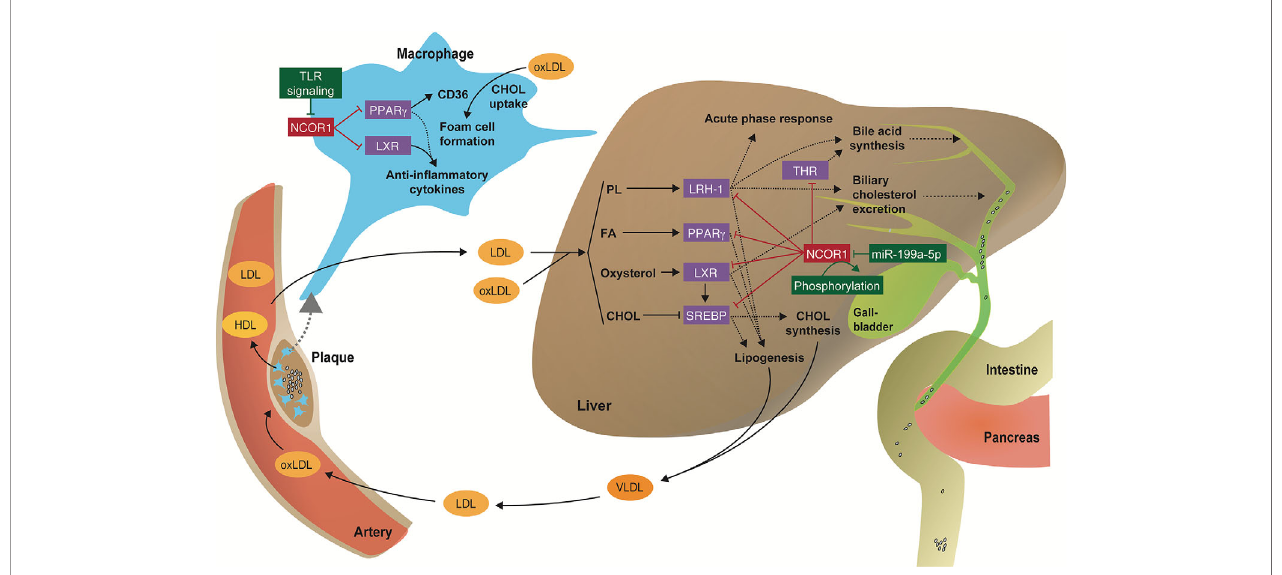
FIGURE 2 | Regulation of immunometabolic processes by the NCOR1 complex. Scheme illustrating how transcriptional corepressor complexes repress the function of nuclear receptors and thus regulate key in fl ammatory and metabolic processes in the liver and macrophages that are involved in the pathophysiology of cardiometabolic diseases. CHOL, cholesterol; FA, fatty acid; oxLDL, oxidized LDL; PL,